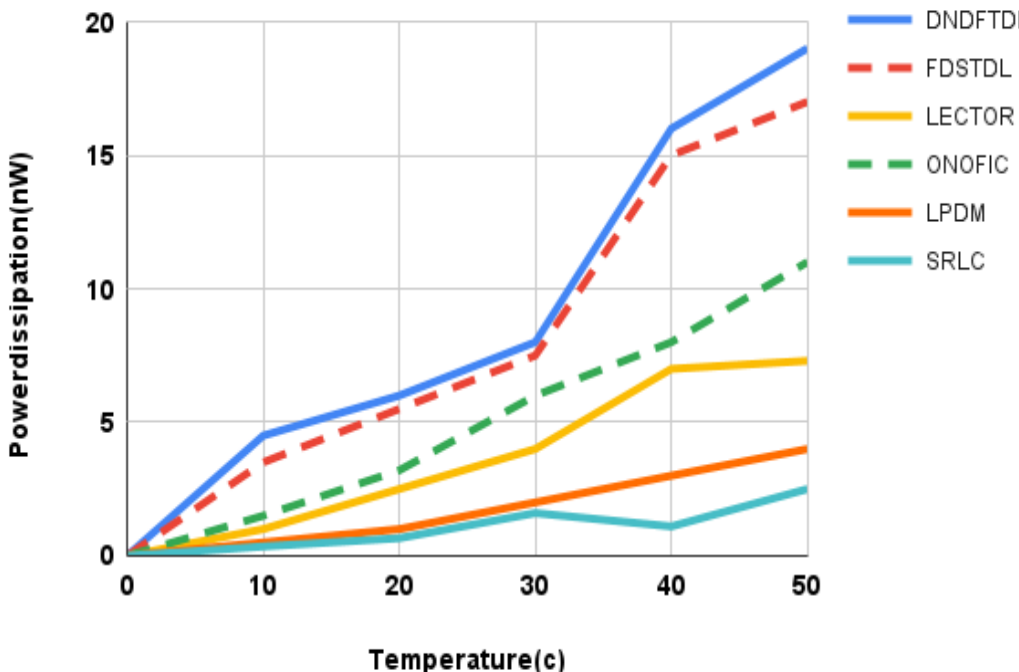
Figure 19. Simulation of power dissipation with varied temperatures of FinFET based SRLC circuit at 7 nm. The abbreviations used in the above table are as follows. CMFD: Current mirror footed logic.